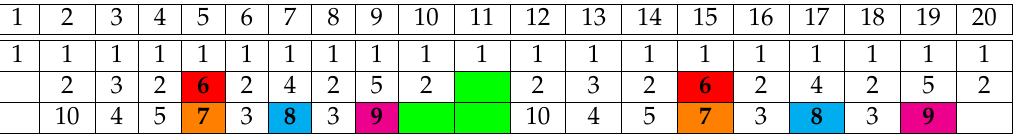
Figure 9. An optimal scheduling for N = C = 10 repeated twice. The distance between the two successive occurrences in red of video segment 6 is equal to 11. The distance between the two successive occurrences in orange of video segment 7 is equal to 11. The distance between the two successive occurrences in cyan of video segment 8 is equal to 10. The distance between the two successive occurrences in magenta of video segment 9 is equal to 10. They are all violating the playback property. Some free slots that could be assigned to some video segments are colored in